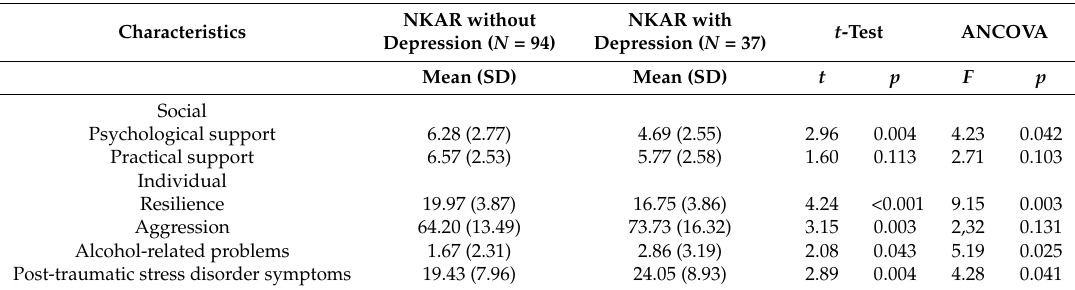
Table 2. Social and individual characteristics of North Korean adolescent refugees (NKAR) with and without depression.